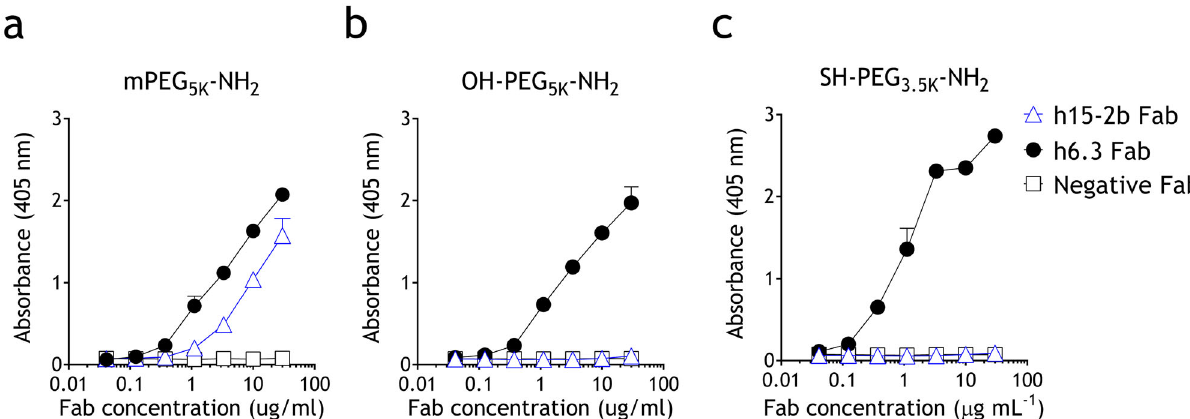
Fig. 1 Characterization of anti-PEG Fab binding to immobilized PEG molecules. Microplate wells coated with amino-PEG molecules terminated ( a ) methoxy, ( b ) hydroxyl, or ( c ) thiol groups were incubated with graded concentrations of backbone-speci fi c (h6.3, black circle) or methoxy-speci fi c (h15-2b, blue open triangle) anti-PEG Fabs or anti-GFP Fab (negative control, open square). After washing, the Fab binding was determined by adding HRP- conjugated goat anti-human F(ab ’ ) 2 fragment speci fi c antibodies, followed by ABTS substrate. The results show the mean absorbance values (405 nm) ± standard deviation ( n = 3). The data are representative of three independent